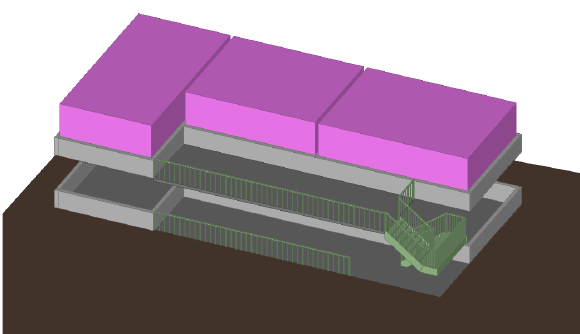
Figure 4. 3D floor plan with legal